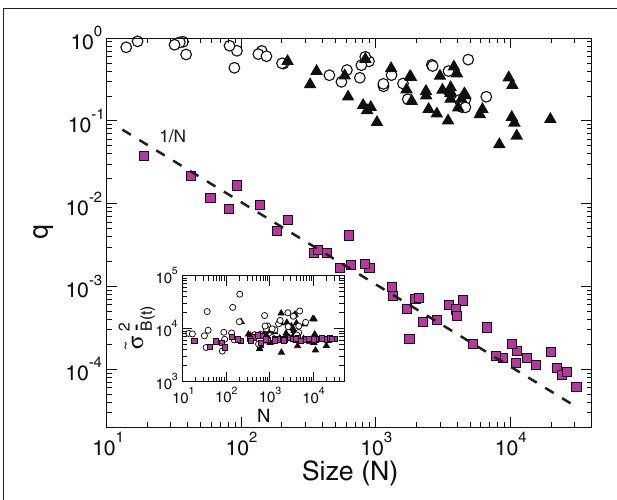
FIGURE 3 | The value of the quotient q , expressing the measured variance relative to its maximum possible value, as a function of cluster size N . Empty circles correspond to the 35 regions derived from the RSN (same as in Figure 2 ) and filled triangles to the 41 Brodmann areas. The filled squares, obeying the 1 / N scaling (dashed line), correspond to clusters of different sizes constructed from a random selection of voxels. The inset shows the average maximum of the BOLD signal variance of a ) as a function of N cluster ( ˜ σ 2 B ( t )